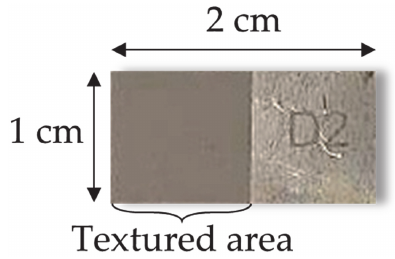
Figure 2. Dimensions of the 316L sample.